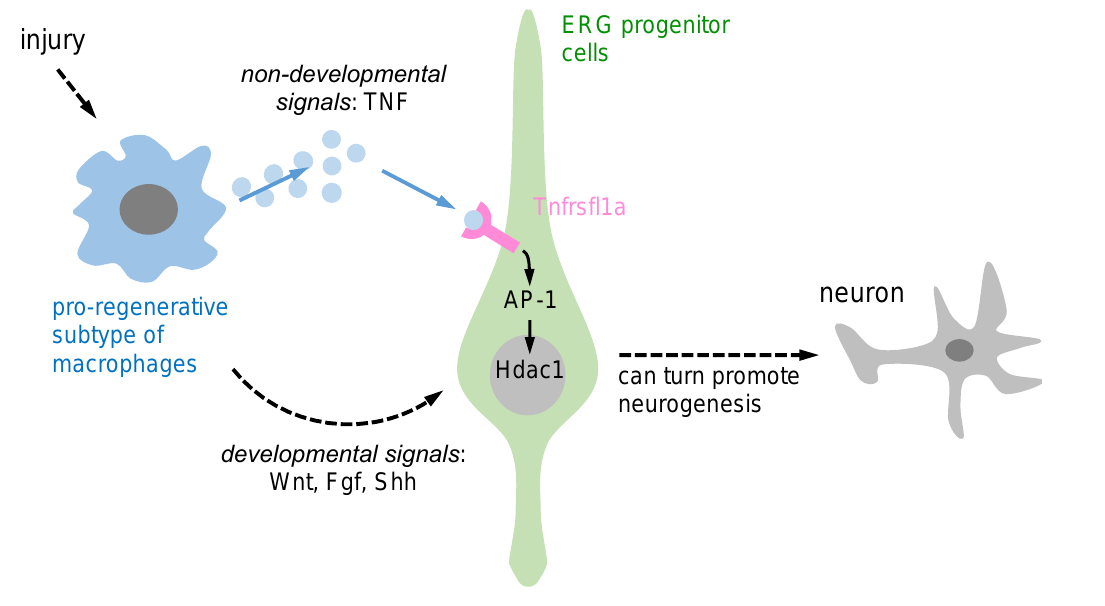
Figure 1. A schematic representation is provided to illustrate the activation of ERG progenitors by pro-regenerative macrophages, which in turn promote neurogenesis through two distinct signaling pathways. Pro-regenerative macrophages utilize two different signaling pathways to induce epen- dymo-radial glia (ERG) progenitors and promote regenerative neurogenesis. Firstly, through non- developmental signals, macrophages secrete TNF- α, which induces Tnfrsf1a -mediated AP-1 activ- ity in ERG progenitors and promotes Hdac1 expression and neurogenesis. Secondly, through de- velopmental signals, macrophage-secreted TNF- α can indirectly impact ERG progenitor cells by in- creasing developmental signals such as Wnt, Fgf, and Shh, promoting regenerative neurogenesis. 5. Macrophages Promote Neuronal Regeneration through ERG Progenitor Cells after